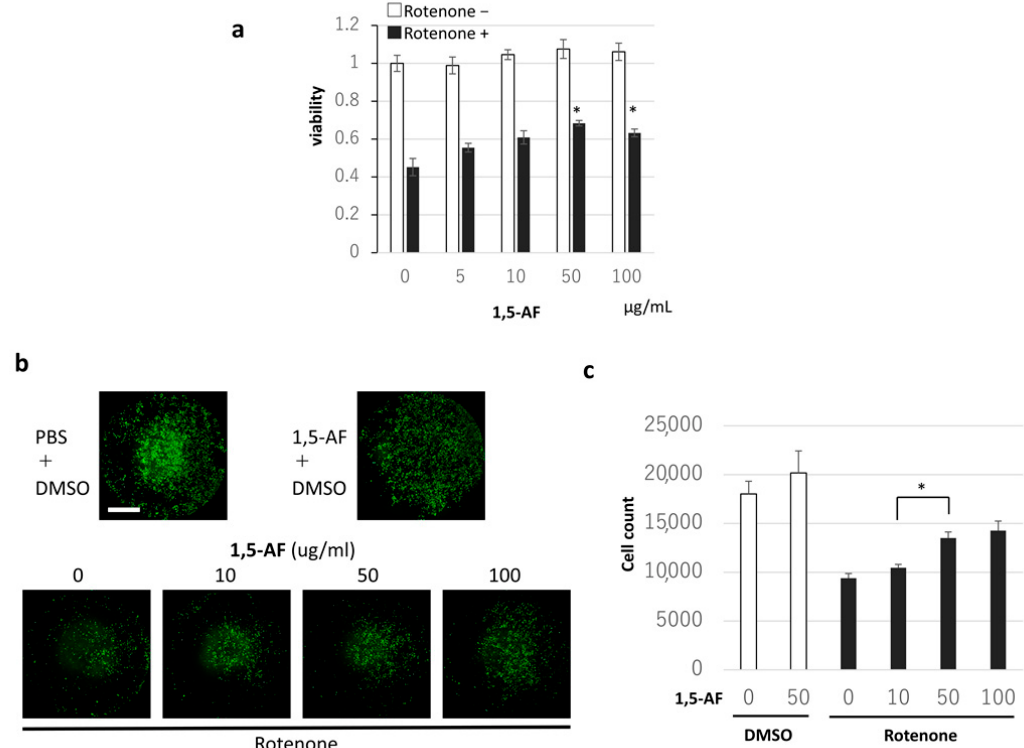
Figure 2. Effects of 1,5-AF against rotenone-induced cytotoxicity in cultured PC12 cells. ( a – c ) Cells were incubated with control solvent (DMSO) or rotenone for 24 h; viable cells were then counted to evaluate the cytotoxic effects of rotenone in this cell line. ( a ) The addition of 1,5-AF had cytoprotective activity against rotenone-induced cytotoxic effects when evaluated by MTT assay (two-way ANOVA). ( b ) Representative confocal images of calcein AM-stained cells showing the dose-dependent cytoprotective effects of 1,5-AF against rotenone (magnification: 4×; scale bar: 2000 µm). ( c ) Quantification of the dose-dependent cytoprotective effects of 1,5-AF from the confocal images of calcein AM-stained cells (one-way ANOVA). Data represent mean cell counts using BZ-X Analyzer software. All data are expressed as the mean ± standard error of the mean. * p < 0.05. 1,5-AF, 1,5-anhydro-D-fructose; DMSO, dimethyl sulfoxide; PBS, phosphate-buffered saline.